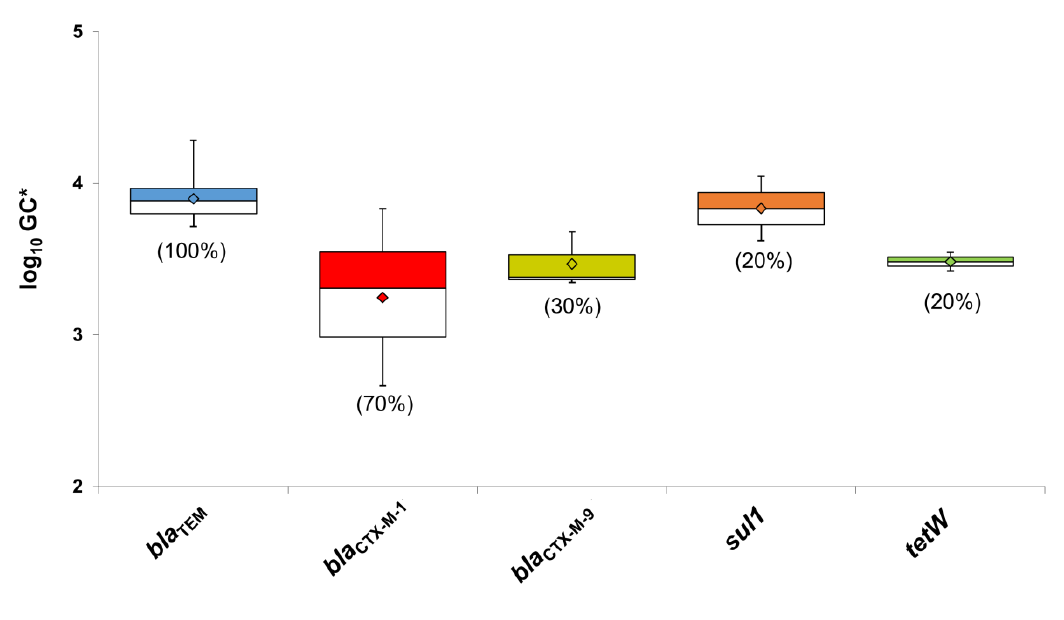
Figure 3. Abundance of ARGs in the phage DNA isolated from phage particles induced from Antarctic bacterial communities present in one liter of Antarctic seawater (log 10 GC / L). Data are represented in boxplots; the diamond represents the average value of the positive samples, the upper squares include samples whose values are within the 75th percentile, and those in the lower white boxes are within the 25th percentile.